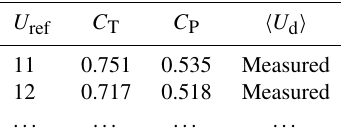
Table 2. Example of the table defining the relation between the average velocity on the disk ( (cid:104) U d (cid:105) ) and the reference operational velocity of the WT ( U ref ), with the corresponding coefficients C T and C P . The values were calculated using the ADM-airfoil and corresponds to inflow velocities below and above rated velocity ( U ref = 11 . 4ms − 1 ) for the NREL 5MW.